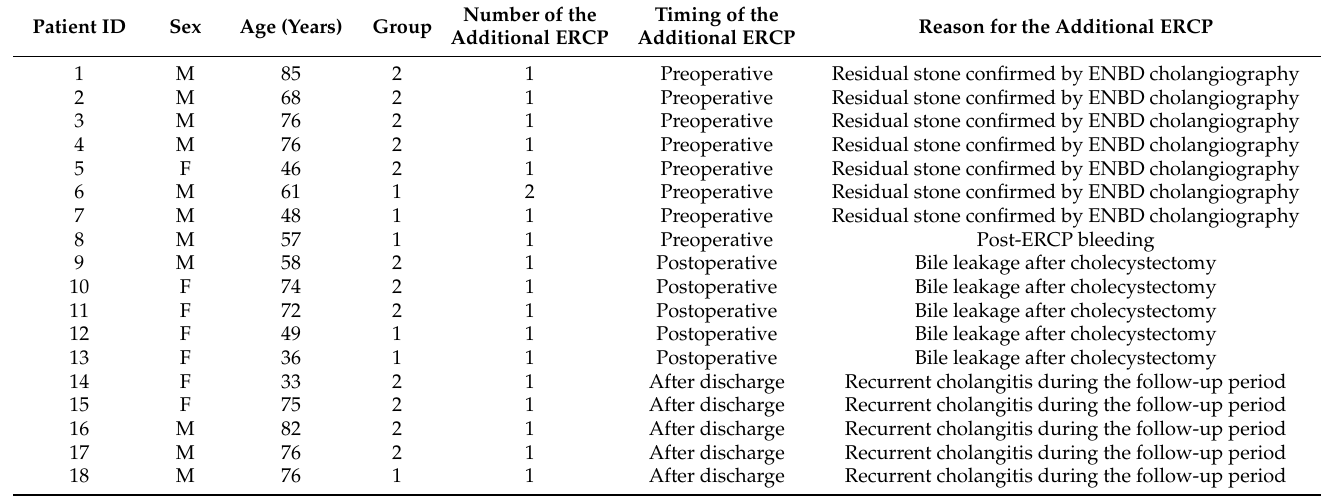
Table 3. The details of the patients who underwent additional ERCP.